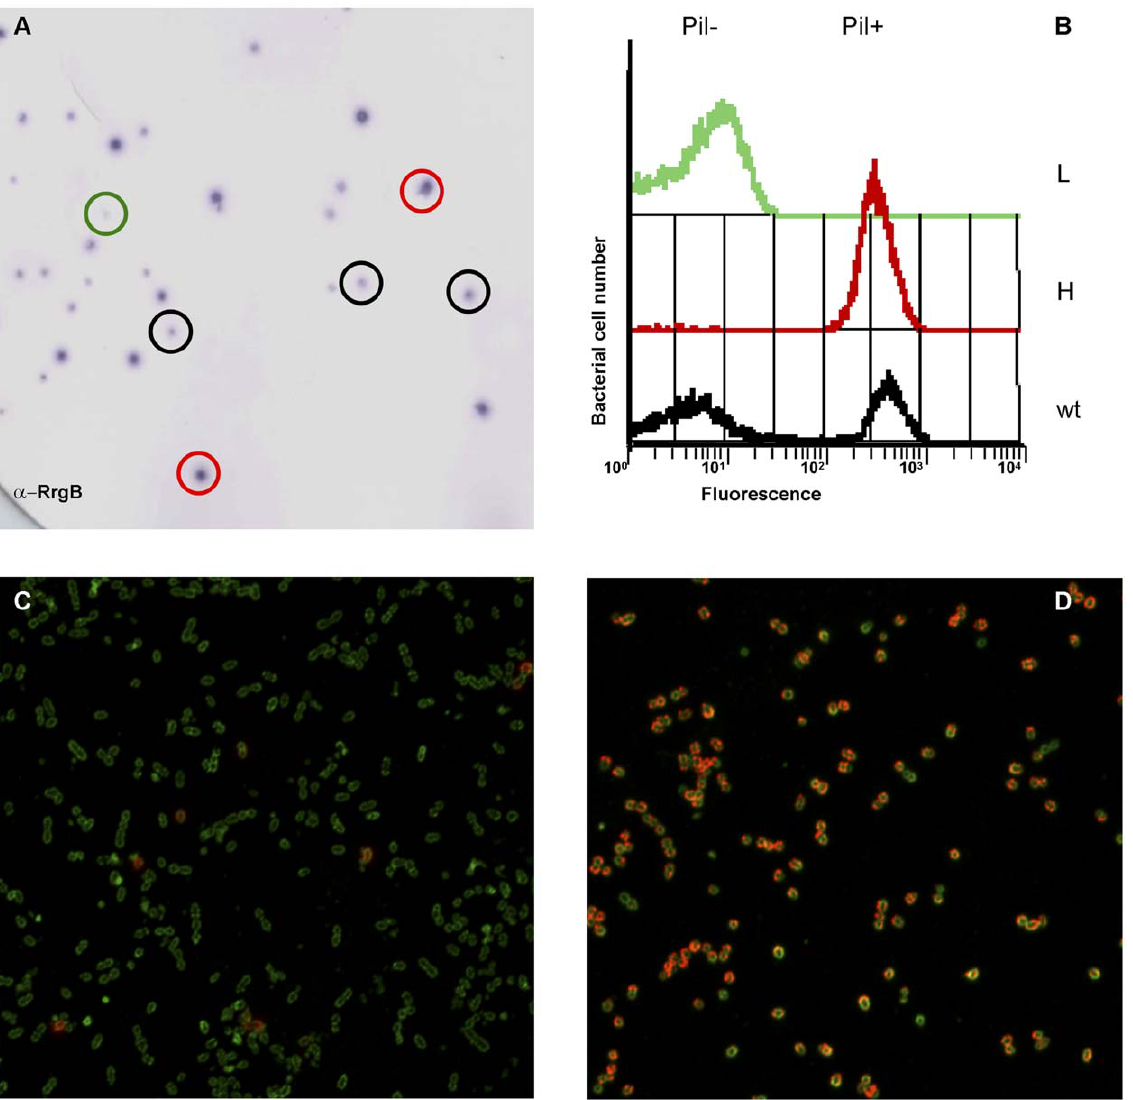
Figure 3. Stable separation of enriched high (H) and low (L) pilus-1 expressing sub-populations. A) TIGR4 pilus-1 expression was revealed on single colonies by colony immunoblot using anti-RrgB clade I antibodies (green, black and red circles correspond to colonies displaying low, medium or high RrgB specific signal intensities, respectively). Bacteria recovered from the growth of different colonies were stained with anti- RrgB clade I antibodies and analyzed by flow cytometry (B). The bacteria expressing (Pil + ) and non- expressing (Pil-) the pilus-1 are indicated in the L (green) and H (red) enriched sub-populations, and in the wt (black). H and L sub-populations were stained for immunofluorescence (C and D). Bacteria were incubated with mouse anti-RrgB antibodies (1:2000 dilution) (red) and with S.pneumoniae anti-capsular antibodies (Omniserum 1:2000 dilution) (green). Imaging was performed with a confocal microscope. Scale bar is 5 m m.